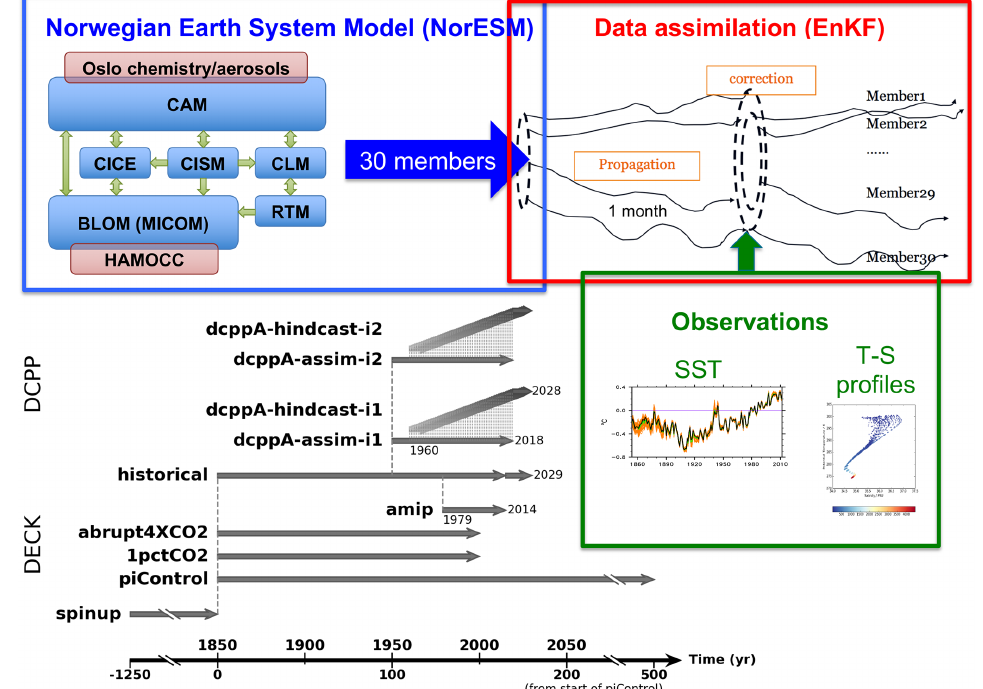
Figure 1. Schematic of NorCPM1 and its contribution to